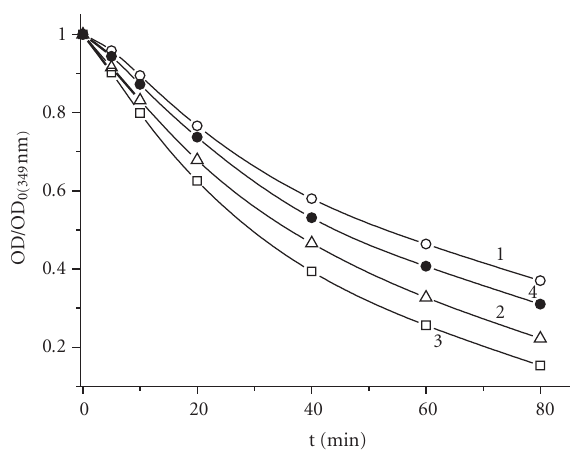
Figure 4: UV-Vis absorption spectra changes in 2,4-dinitroaniline (5 · 10 − 5 M) degradation under irradiation ( λ = 254nm, P 0 = 3 · 10 − 7 einstein · dm − 3 · s − 1 ) in the presence of TiO 2 / ZrO 2 (5%) film ( m = 0 . 001g). Spectra were registered every 30min. Inset: initial reaction rates of photooxidation versus Zr concentration in TiO 2 / ZrO 2